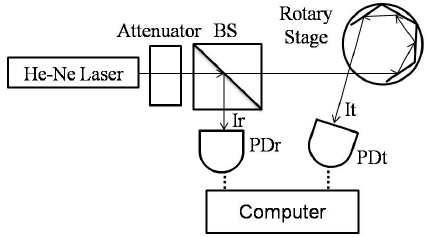
Figure 5. Experimental architecture.